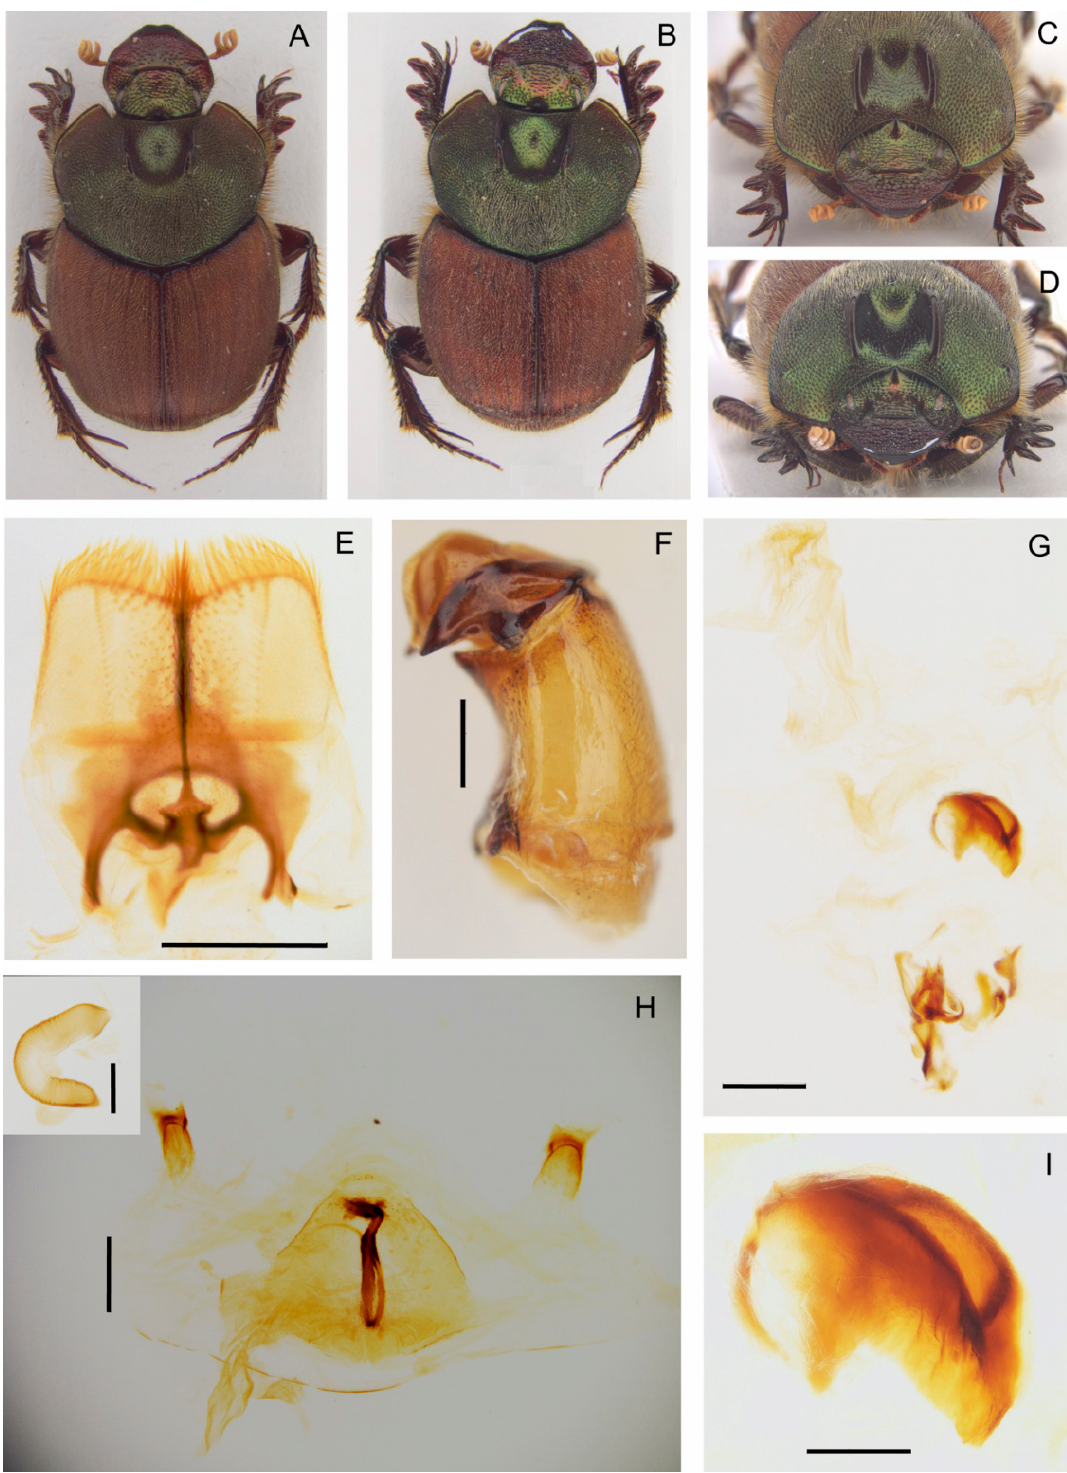
Figure 12. Features of Tiaronthophagus saadaniensis n.sp. (A) : Male facies (above). (B) : Female facies (above). (C) : Male facies (frontal view). (D) : Female facies (frontal view). (E) : Epipharynx scalebar = 1.0 mm. (F) : Male genitalia, phallobase and parameres, scalebar = 0.5 mm. (G) : Male genitalia, endophallus, scalebar = 0.5 mm. (H) : Female genitalia, vagina, scalebar = 0.3 mm, and receptaculum seminis, scalebar = 0.2 mm. (I) : Male genitalia, lamella copulatrix, scalebar = 0.2 mm.